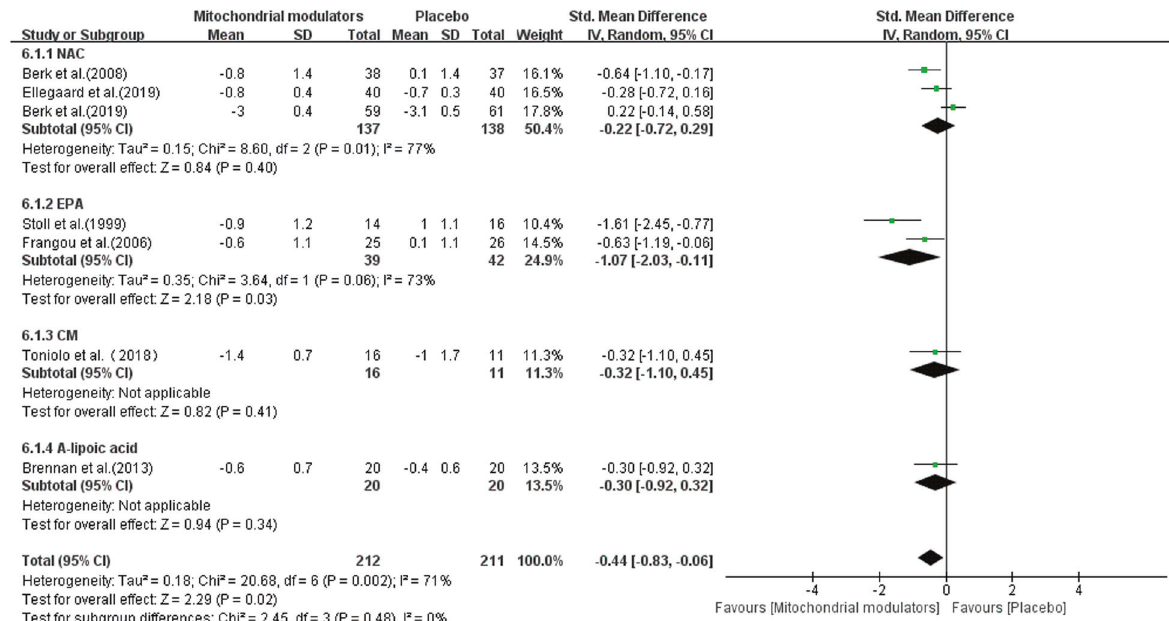
Fig. 5 Forest plots for CGI-S reductions with mitochondrial modulators. CM creatine monohydrate, EPA eicosapentaenoic acid, NAC N- acetylcysteine, SD standard deviation, SMD standard mean